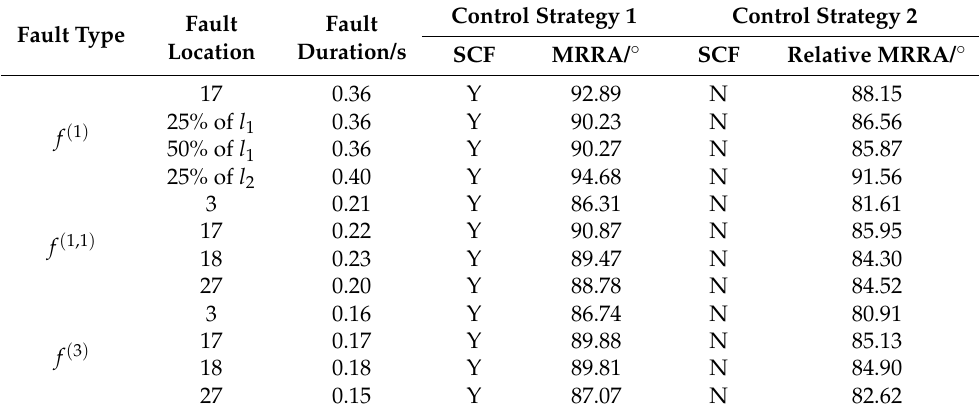
Table 1. Comparison of simulation results by different control strategies in different scenarios. Fault